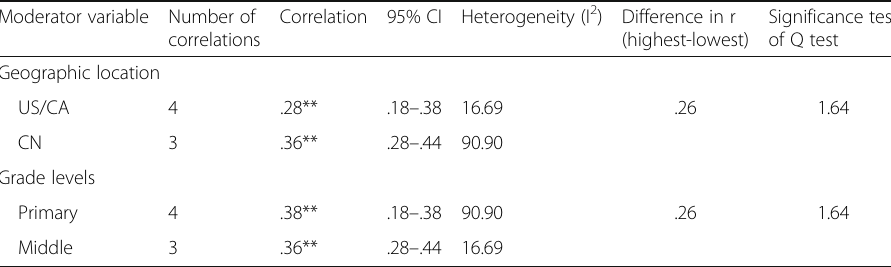
Table 5 Number of correlations, correlation, 95% confidence interval, heterogeneity statistics, difference in r between categories and significance test of categories for moderators of the relationship between Chinese and English morphological